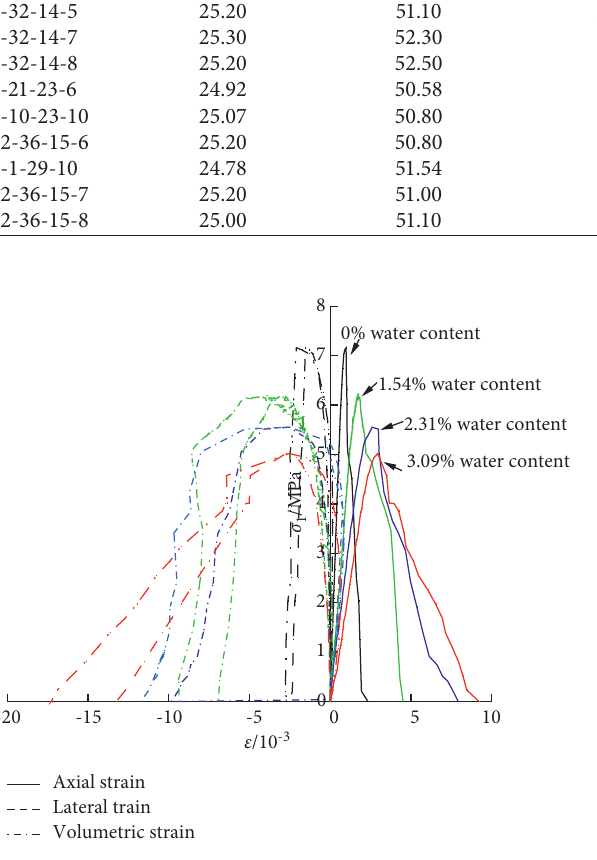
Figure 2: Total stress-strain curves with different water contents under uniaxial compression.